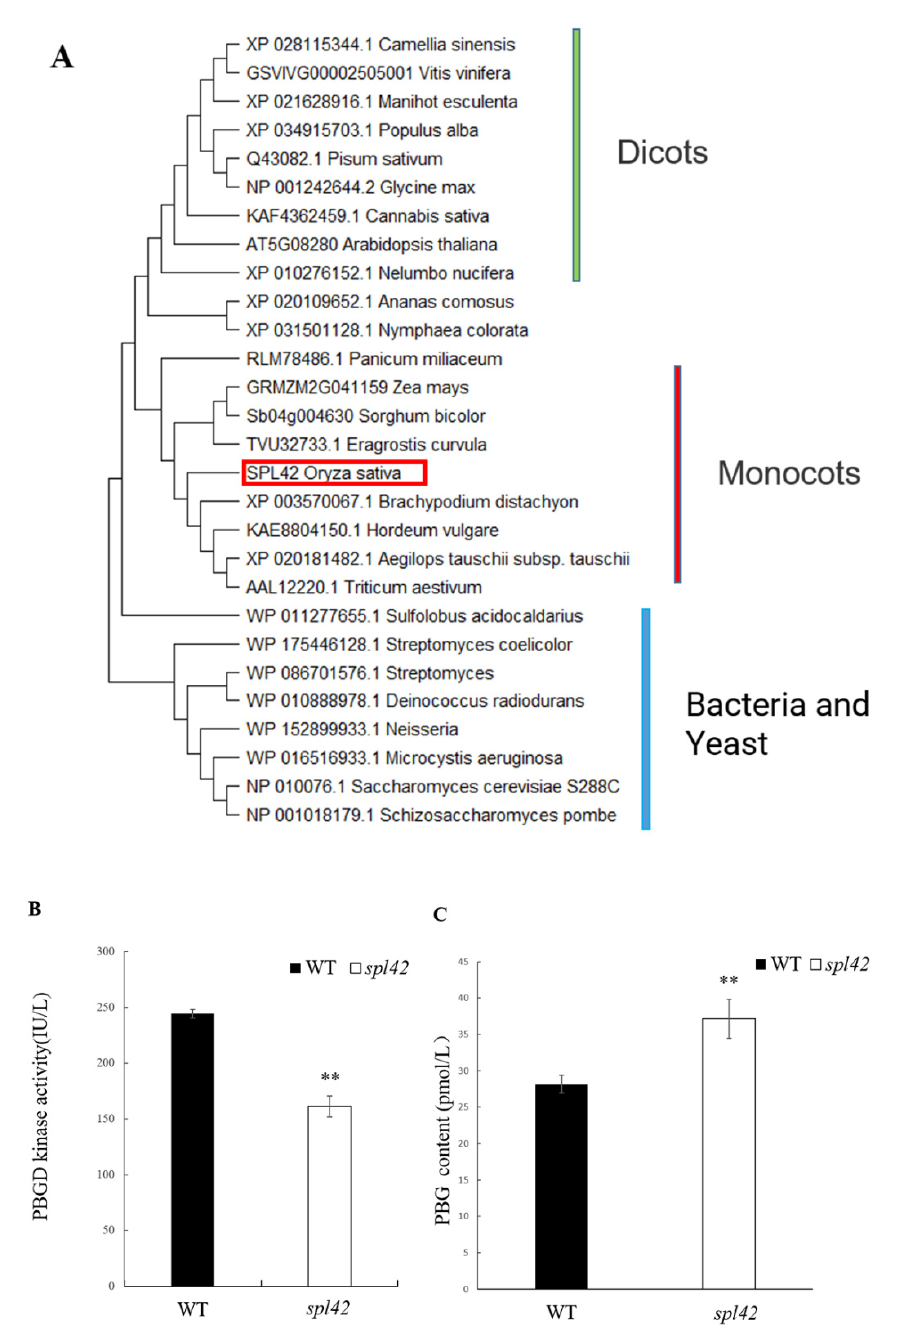
Figure 7. Phylogenetic tree analysis of SPL42 and enzyme properties of porphobilinogen deaminase (PBGD). ( A ) Phylogenetic tree analysis of SPL42 protein (boxed) with homologous proteins. The rooted tree using percentage identities is based on a multiple sequence alignment generated with the program MEGA-X. Scale represents percentage substitution per site. ( B ) Enzyme activity analysis of porphobilinogen deaminase (PBGD) in wild type (WT) and spl42 mutants. Error bars represent ± SD ( n = 3). ( C ) porphobilinogen (PBG) content of the precursor of enzyme reactions in wild type and spl42 mutants. Error bars represent + SD ( n = 3). Asterisks indicate a significant difference between WT and the spl42 plants by Student’s t-test, ** p < 0.01.